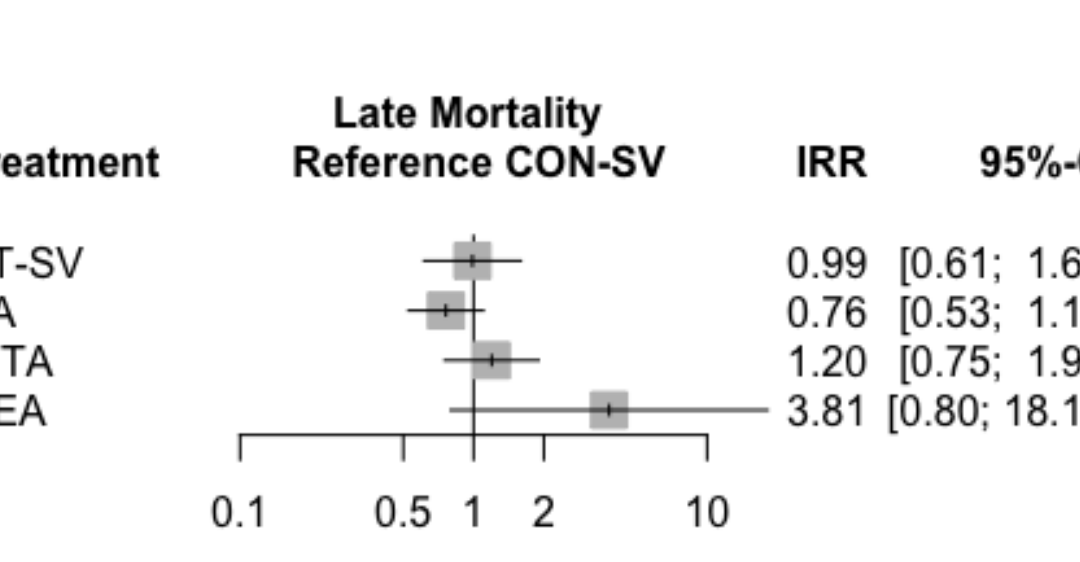
Fig. 3 - Forest plot for late mortality for the different conduits. CI=confidence interval; CON-SV=conventionally harvested saphenous vein; GEA=gastroepiploic artery; IRR=incidence rate ratio; NT-SV=no-touch saphenous vein; RA=radial artery; RITA=right internal thoracic